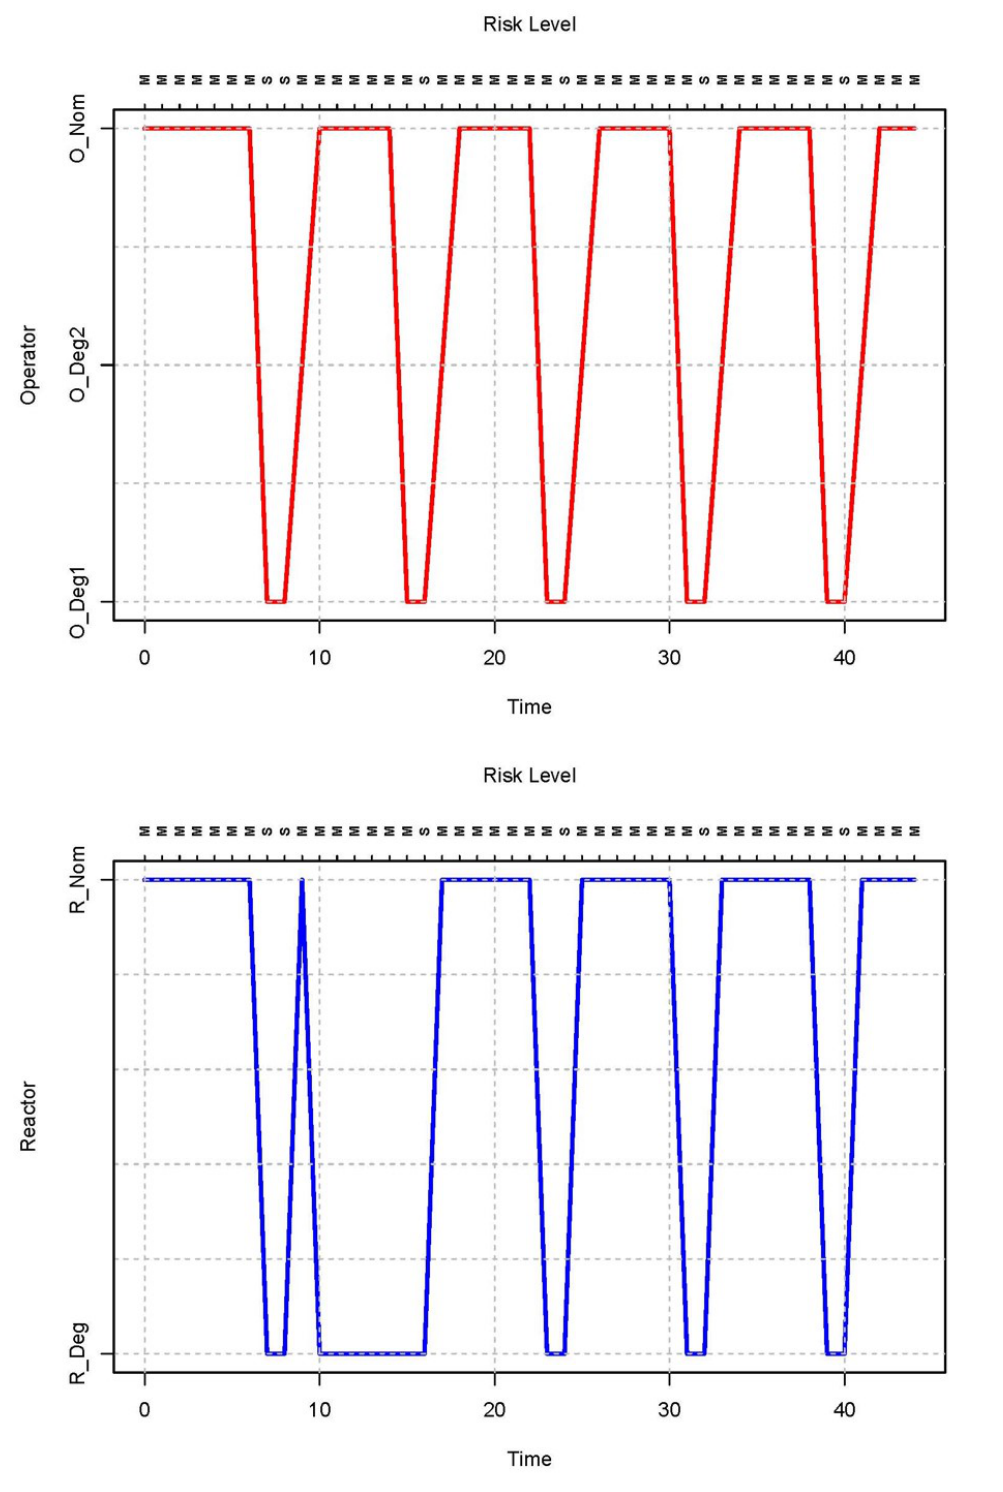
Figure 18. Agent’s behavioral modes with the related Risk Level during simulation